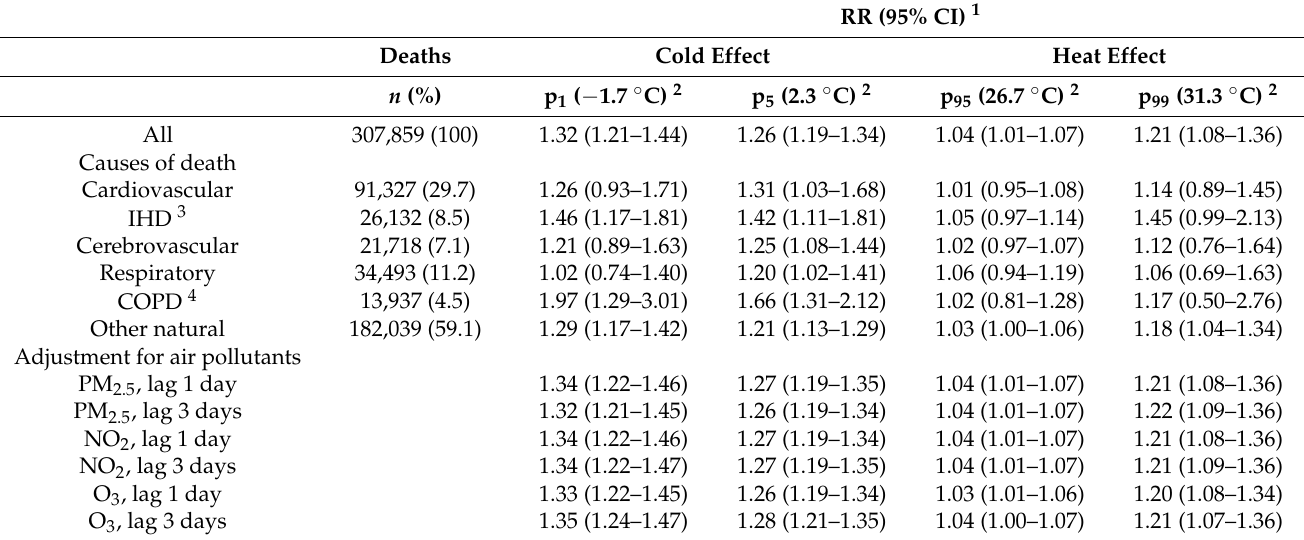
Table 2. Cold effect (1st and 5th percentiles of temperature versus minimum-mortality temperature) and heat effect (95th and 99th percentiles of temperature versus minimum-mortality temperature) of temperature on mortality cumulated over lags of 0–21 days,